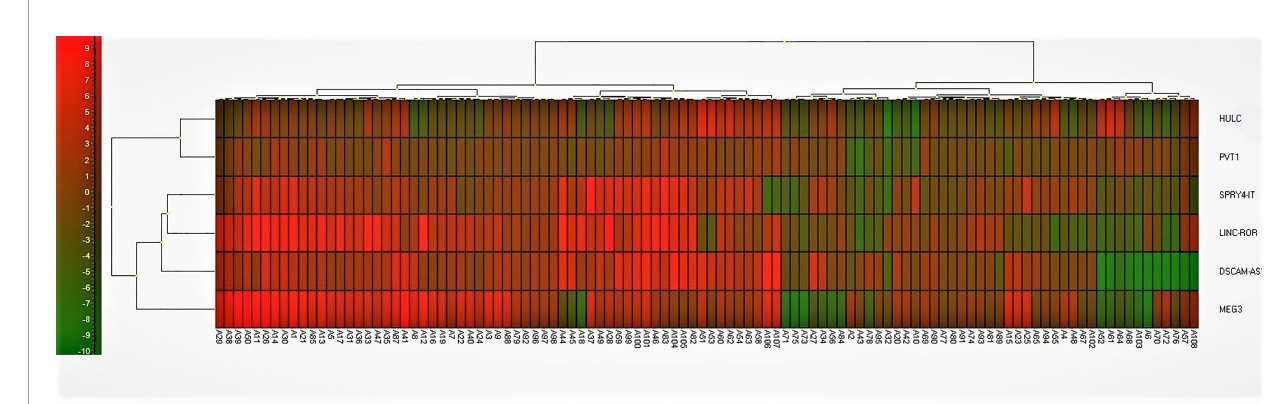
FIGURE 7 | Log2 Fold Change Heat Map. A heat map for the subjects with Parkinson diseases and healthy control. Log2 fold change was calculated based on delta Ct value compared to the control samples. Red color implies increased expression while green implies decreased expression. LncRNAs on the right are clustered using a hierarchical clustering method (Ward ’ s method, Euclidean distances) and 5 clusters were found. Cluster 1 = HULC and PVT1; Cluster 2 = SPRY4- IT; Cluster 3 = LINC-ROR; Cluster 4 = DSCAM-AS1; Cluster 5 = MEG3. Most of patient samples (A1-A50) were located on the left side with increased expression of lncRNAs studied in this